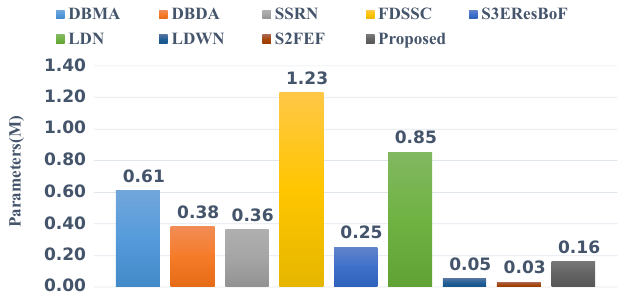
Figure 9. Size comparison of the models.